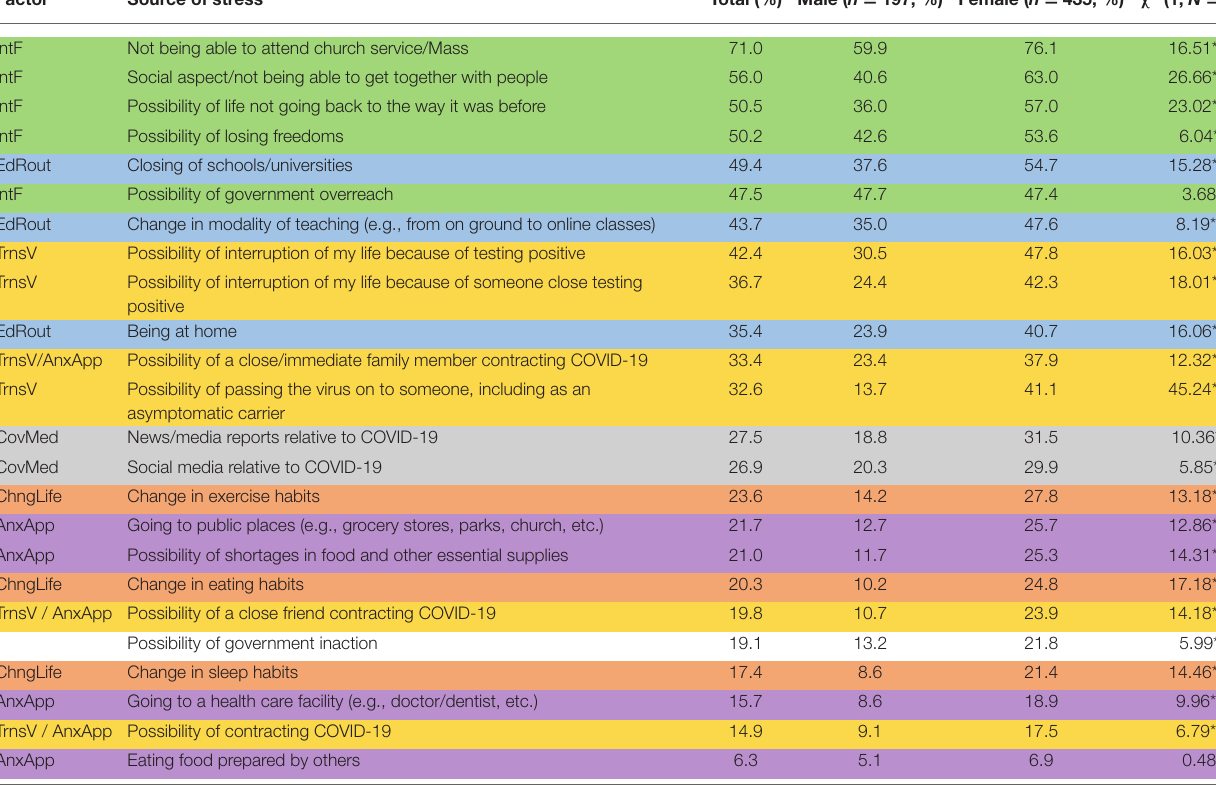
TABLE 3 | COVID-19 sources of stress.